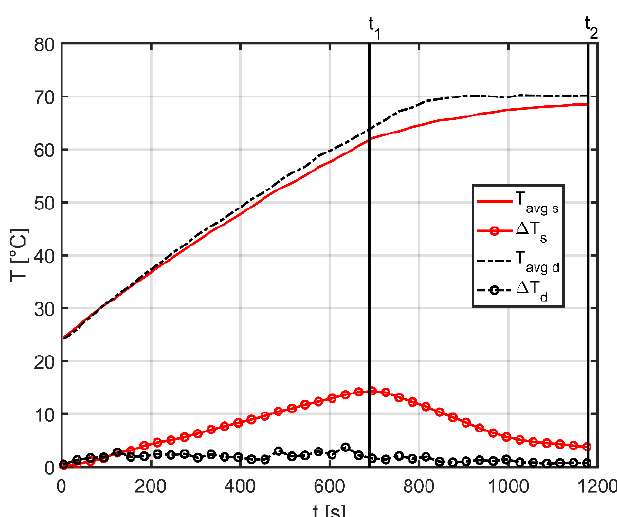
Figure 18. Temperature waveforms of the cylinder surface during heating (averaged values along the perimeter of the cylinder, T avg , and the irregularity indicators of the temperature profiles along the cylinder generatrix; s — systematic algorithm; d — dedicated algorithm).